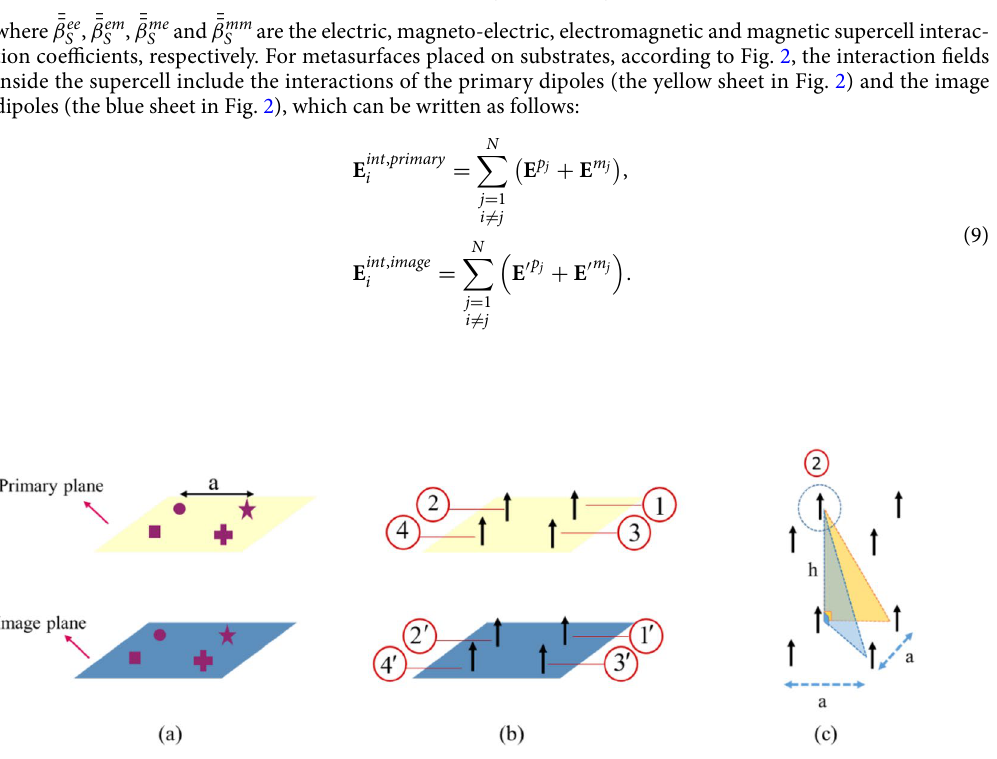
Figure 2. The selected supercell and its equivalent electric-dipole